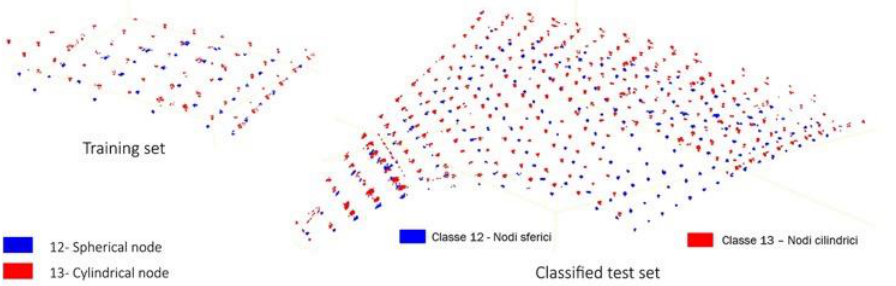
Figure 17. Training set and classification results at the second classification level: Classes 12 and 13.